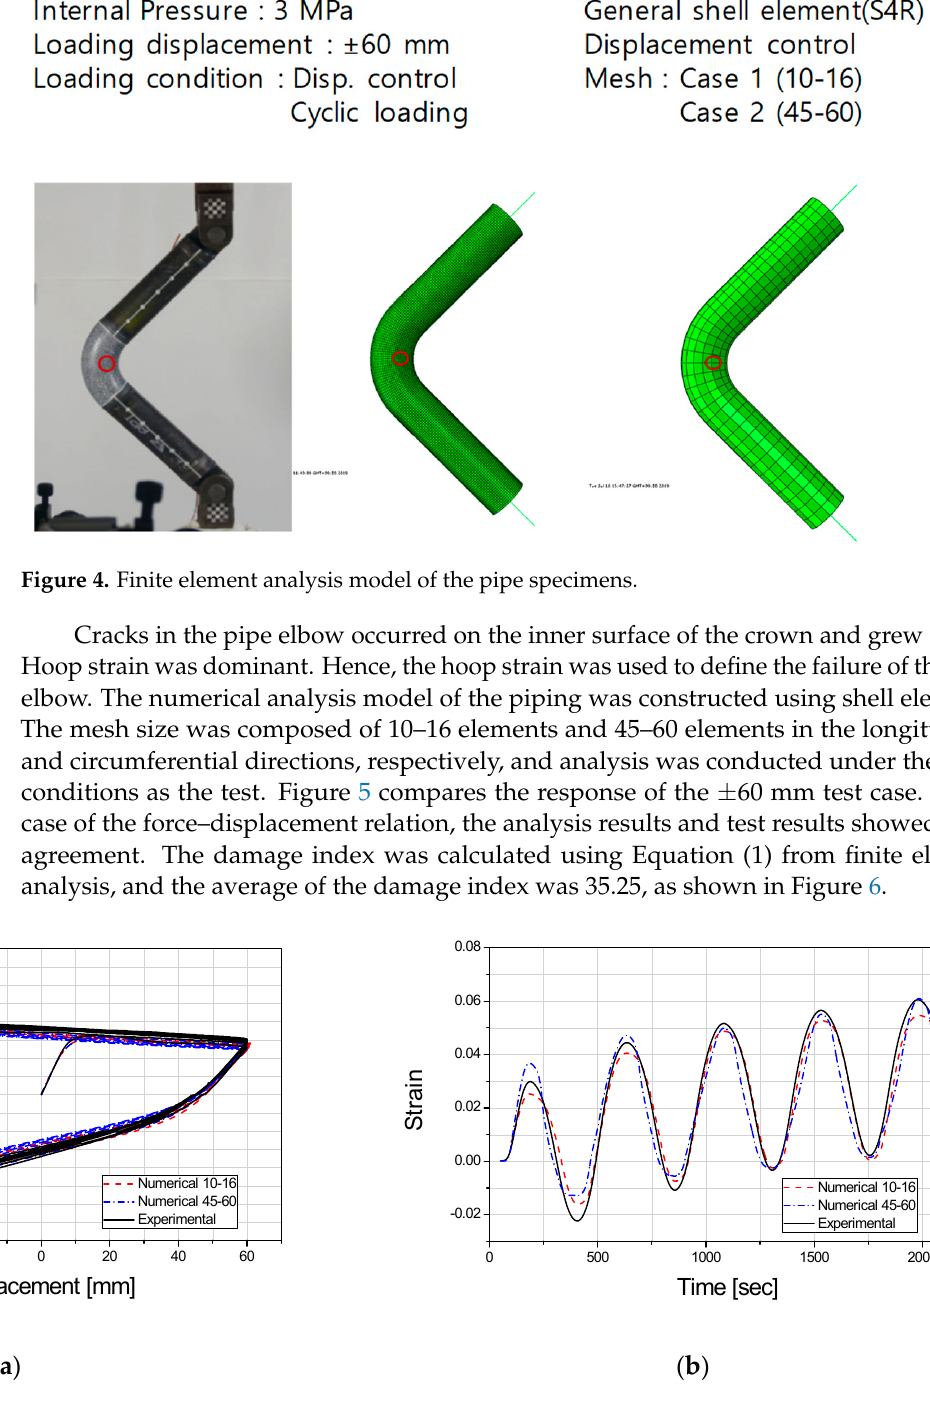
Figure 5. Comparison of the experimental and finite element analysis results: ( a ) comparison of the force–displacement response; ( b ) comparison of the strain response.